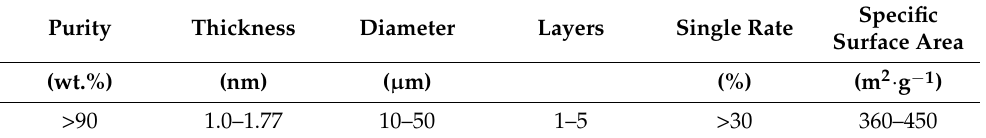
Table 2. Property of